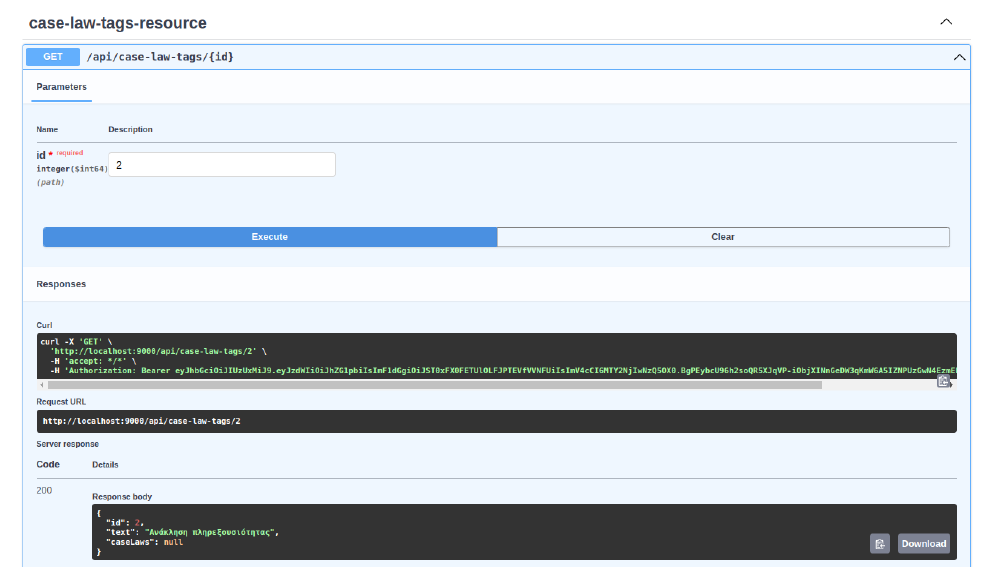
Figure A3. Screen capture of sending a REST API request and displaying its result through our documentation page’s